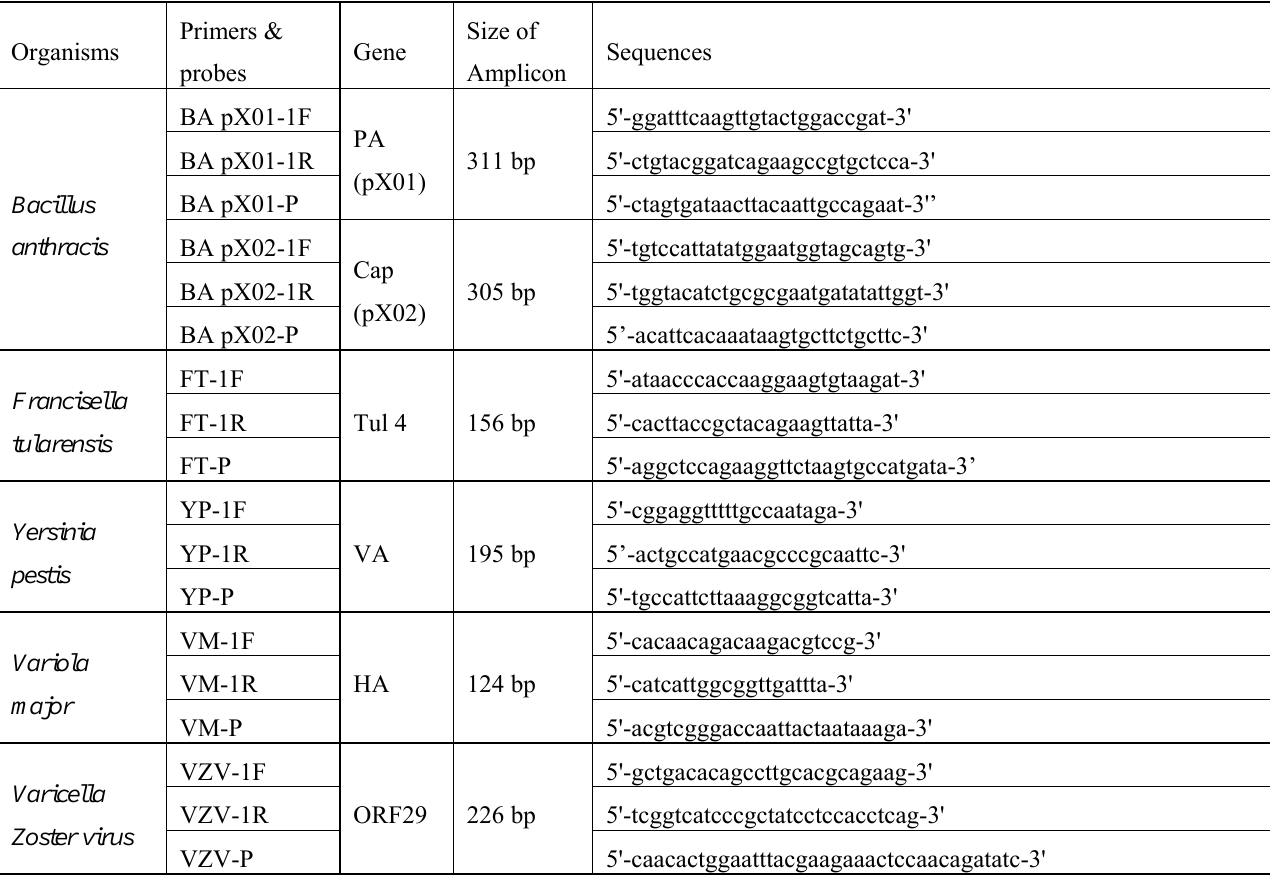
Table 5A. Primer and probe sequence using in the BioT DNA multiplex PCR-EHA assay.